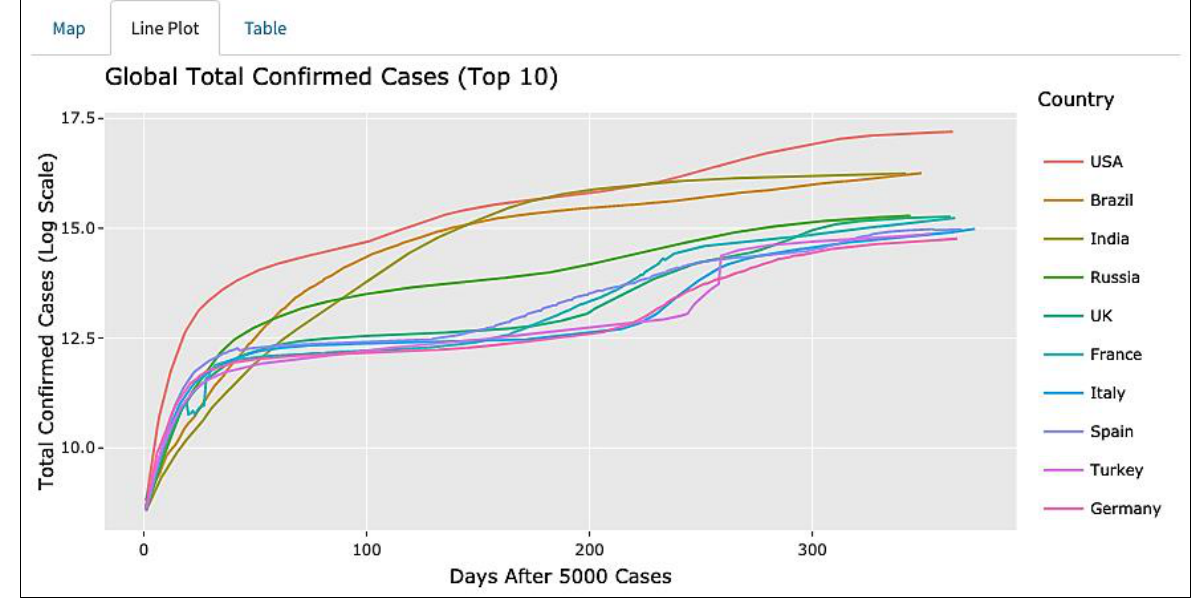
Figure 3. Global Confirmed Cases Time-Series Line Plot